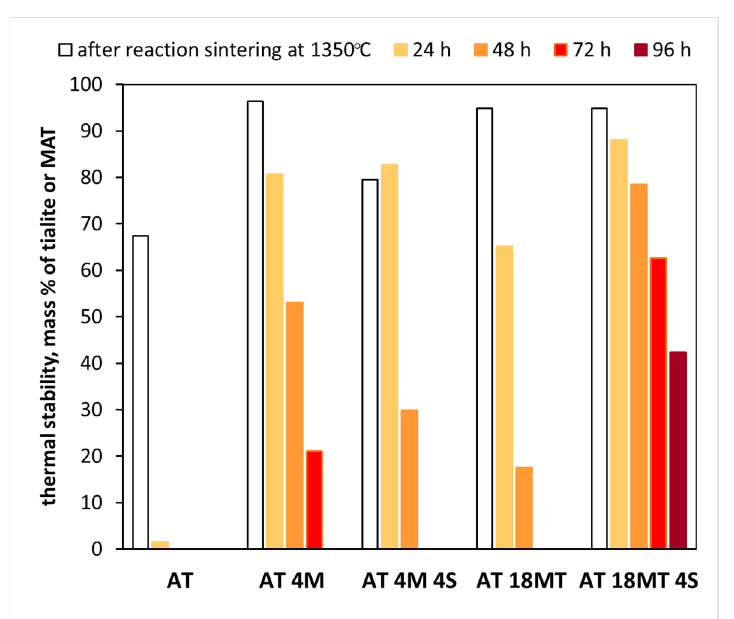
Figure 6. Thermal stability of AT, AT 4M, AT 4M 4S, AT 18MT, and AT 18MT 4S systems after annealing at 1100 °C for 24, 48, 72, and 96 h.